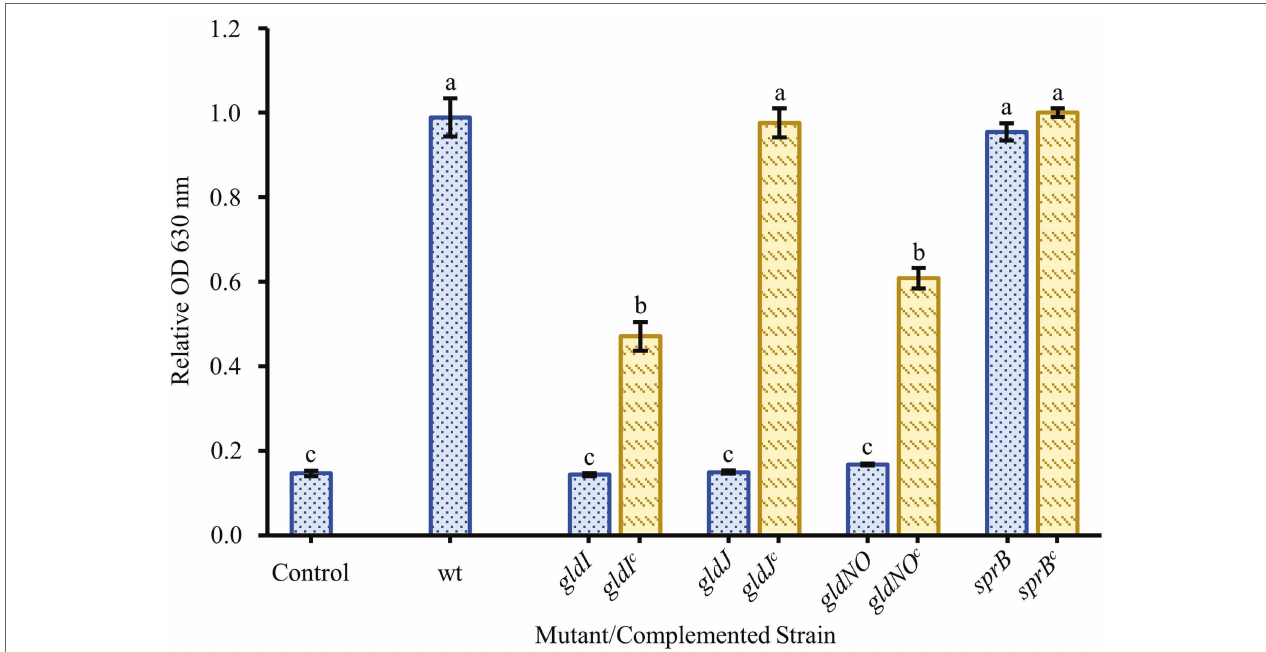
FIGURE 3 | Effect of motility and type IX secretion system (T9SS) gene deletions on biofilm formation. Biofilm formation was determined for strains with knockouts in genes linked to gliding motility ( gldI , gldJ ), the T9SS ( gldJ , gldNO ), and colony spreading ( sprB ). Knockouts (blue-dotted bars) and complemented knockouts (yellow-dashed bars) of F. johnsoniae were gldI and gldI c : UW102-41 and CJ1171; gldJ and gldJ c : UW102-55 and CJ1111; gldNO and gldNO c : CJ1631A and CJ1640; and sprB and sprB c : CJ1922 and CJ2405. Results are reported as relative OD values (averages of at least four replicates; normalized to the wild type). Error bars indicate 95% CI. Different letters above the error bars represent different significance groups (one-way ANOVA followed by Tukey test, value of p = 0.05).